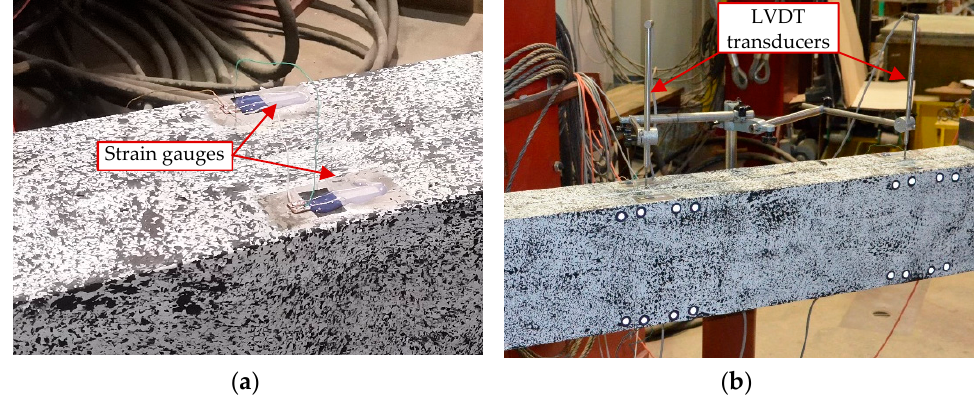
Figure 2. Measuring sensors: ( a ) electrical resistance strain gauges; ( b ) LVDT transducers